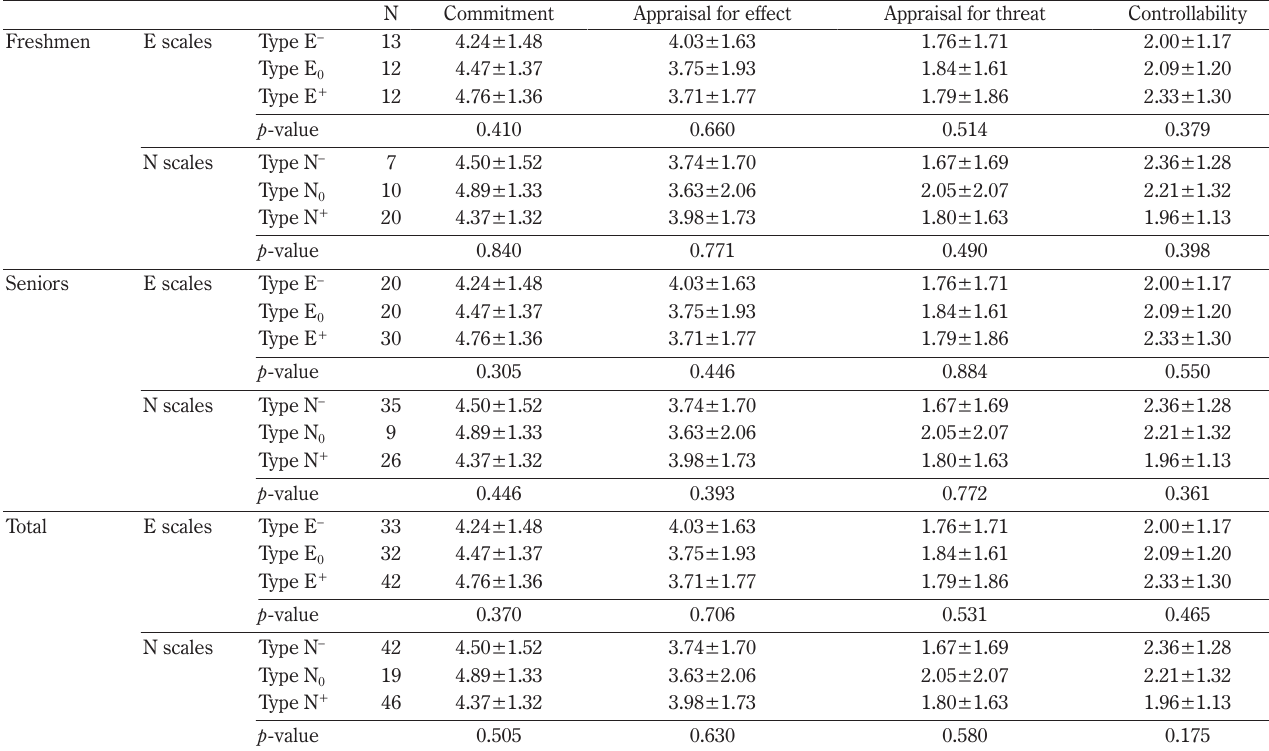
Table 6 Mean/standard deviation and significant difference of CARS for personality traits N Commitment Appraisal for effect Appraisal for